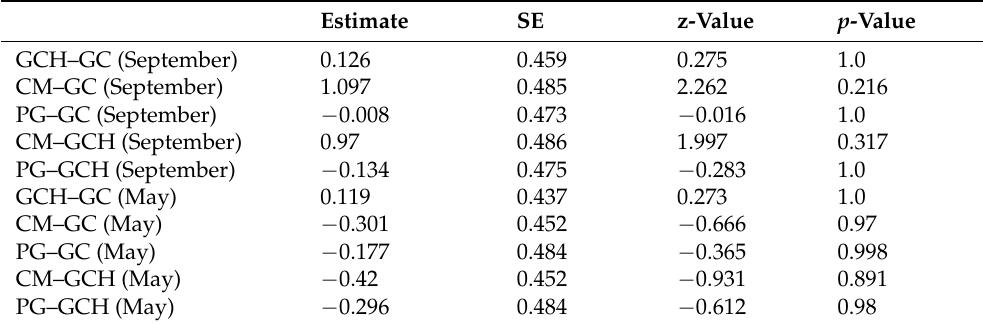
Table A10. Differences in the species richness of eurytopic carabid beetles, comparing grass–clover (GC) and grass–clover herbs (GCH) with each other, and in comparison to conventional maize (CM) and permanent grasslands (PG) in May/June and September.